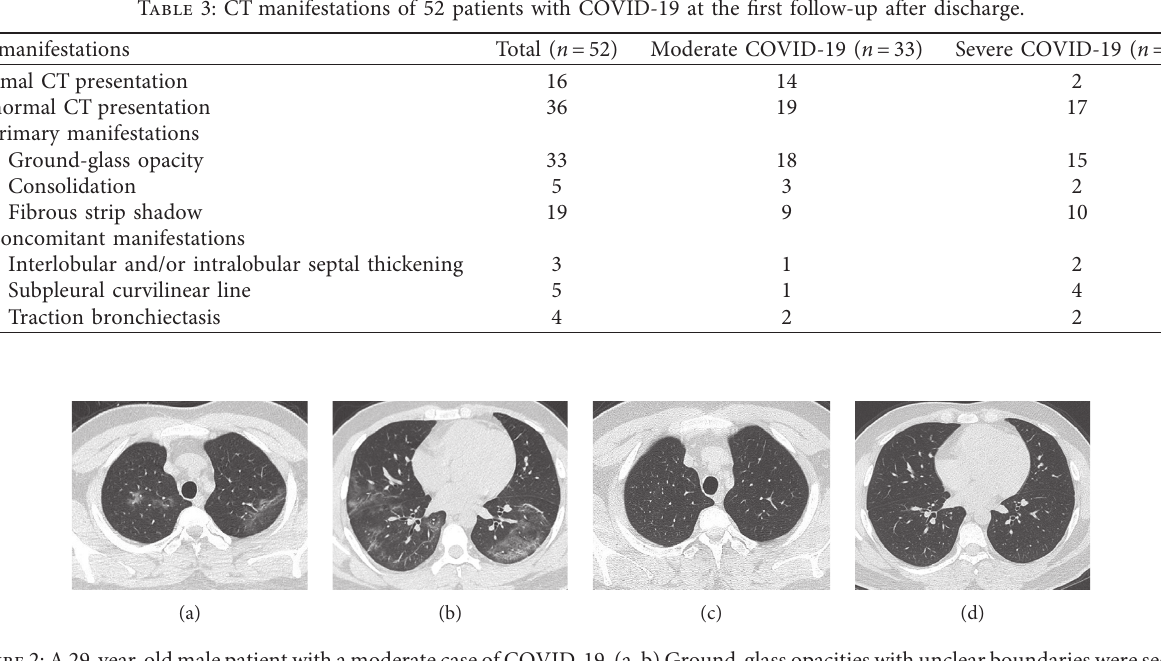
Figure 2: A 29-year-old male patient with a moderate case of COVID-19. (a, b) Ground-glass opacities with unclear boundaries were seen in multiple lobes of both lungs on day 14 after onset of the disease. (c, d) On day 36 after onset and day 20 after discharge, pulmonary lesions dissipated completely.